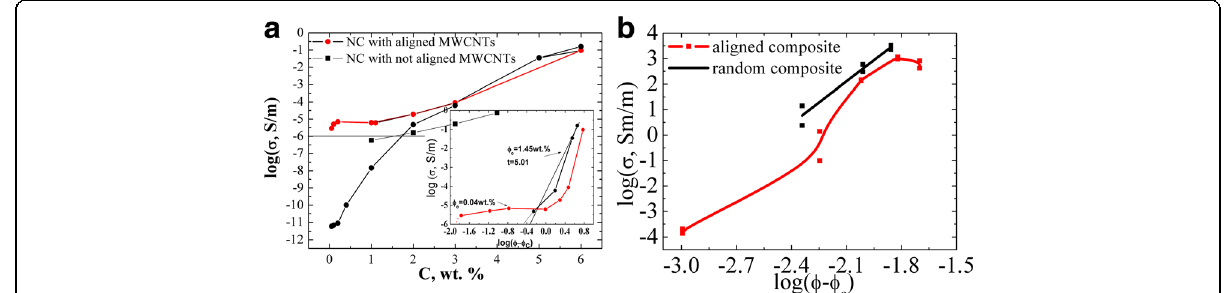
Fig. 11 Concentration dependence of conductivity of MWCNTs/Larit 285 ( а ) [27] and GNPs/Larit 285 ( b ) in log-log